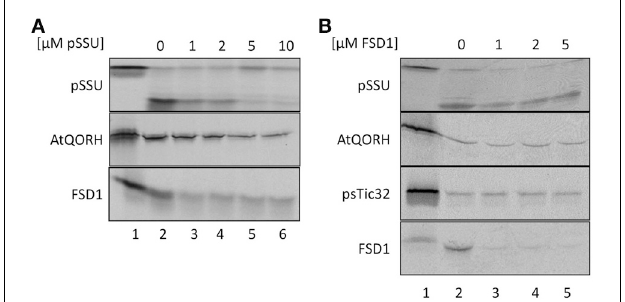
FIGURE 4 | FSD1 import uses parts of the general import pathway. (A) In vitro import assays into pea chloroplasts are depicted. Lane 1 shows 10% of translation product. Increasing amounts of heterologously expressed pSSU as indicated on top of the panel were added to the import reaction. (B) Same as in (A) but with FSD1 as competitor. All samples were treated with thermolysin after import. Representative results from n = 3 independent experiments are